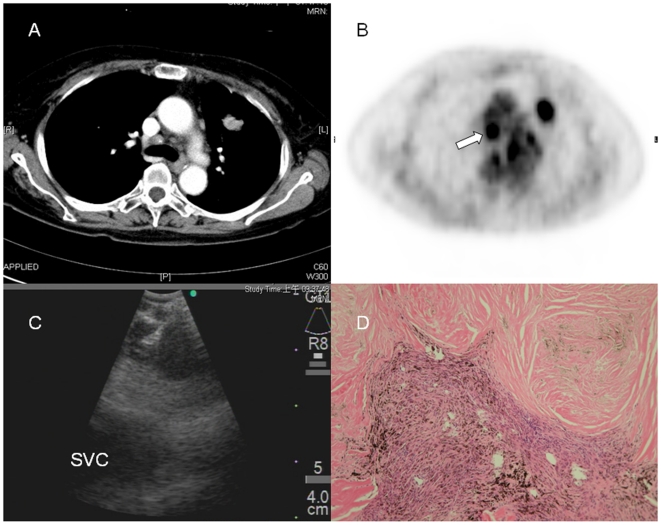
A representative case of a PET scan with negative impact.(A) The contrast-enhanced CT scan shows lymph node measuring 0.8×0.8 cm in para-tracheal area (4R). (B) The PET scan shows strong FDG uptake (arrow) at the corresponding site. (C) Lymph node is targeted by EBUS-TBNA, with the superior vena cava (SVC) lies beneath. (D) The pathology reveals collagenized nodules and anthracotic pigment-laden macrophages (H&E stain, 100X). Silica particles were identified under polarized light (not shown).